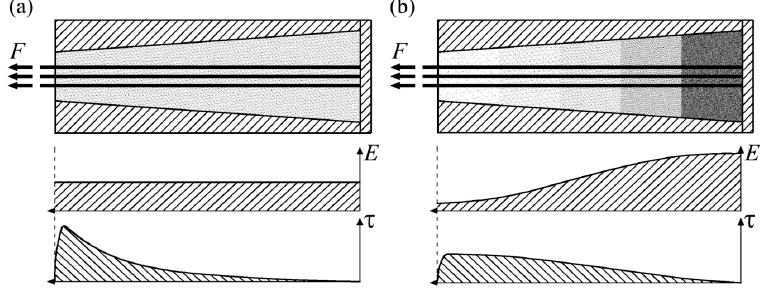
Figure 10. Principle of Gradient Anchorage System: ( a ) normal conical mortar anchorage and ( b ) Gradient Anchorage System.